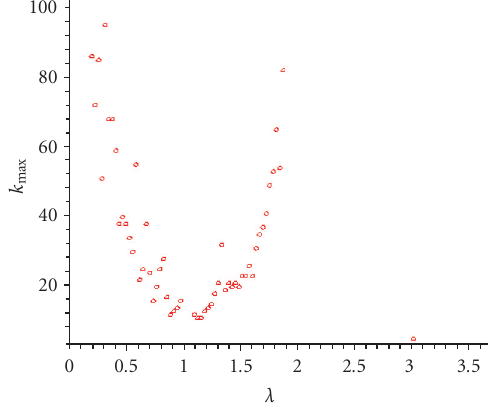
Figure 5.3. Modified Newton algorithm with di ff erent values of λ for a chosen x = − 3 . 417034624.